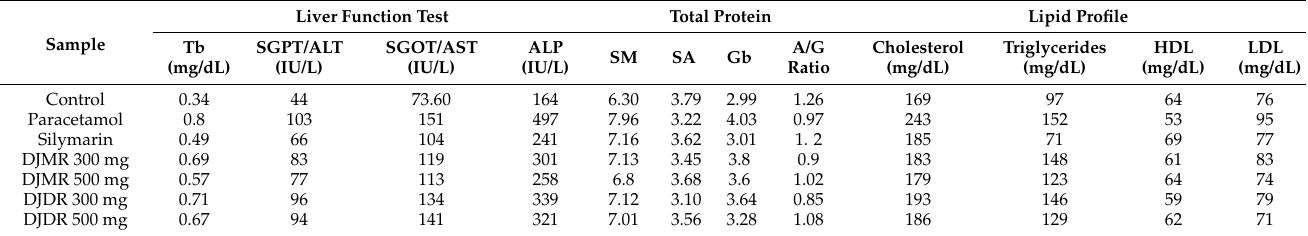
Table 6. Hepatoprotective analysis of D. juxtapostia root dichloromethane and methanol